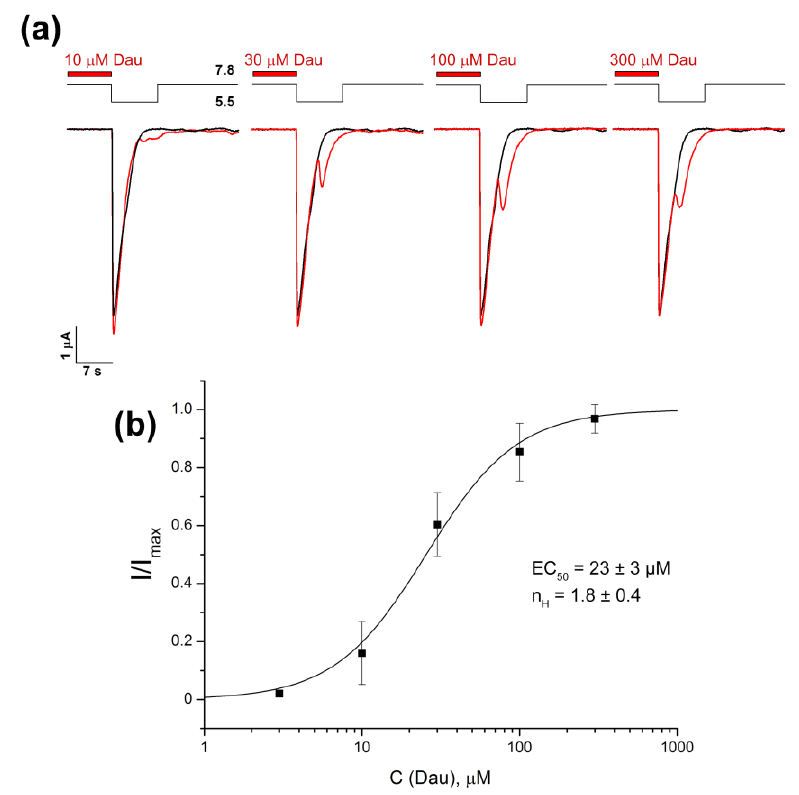
Figure 2. Concentration-dependent activation of the DAU-induced second component of the ASIC1a current. ( a ) Representative whole-cell traces for currents evoked by a fast pH 5.5 stimulus in the control (black) and in the channels that were pre-incubated for 15 s with DAU at various concentrations (red). ( b ) The dose–response curve fitted to the logistic equation for the second component of the ASIC1a current. I / I max is the amplitude of the second component of the current at a conditioning pH of 7.8, normalized to the maximum amplitude (I max ) calculated for each oocyte by individual fitting. Data are presented as mean ± SEM (n = 6).